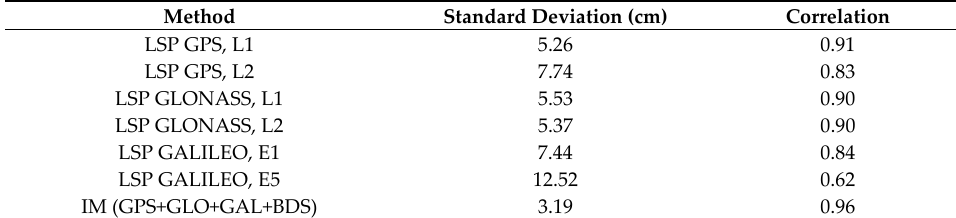
Table 1. Results of GNSS-R for sea height estimation in BCL1